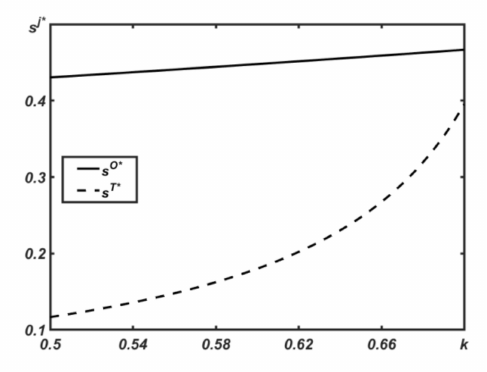
Figure 2. Variations of s i ∗